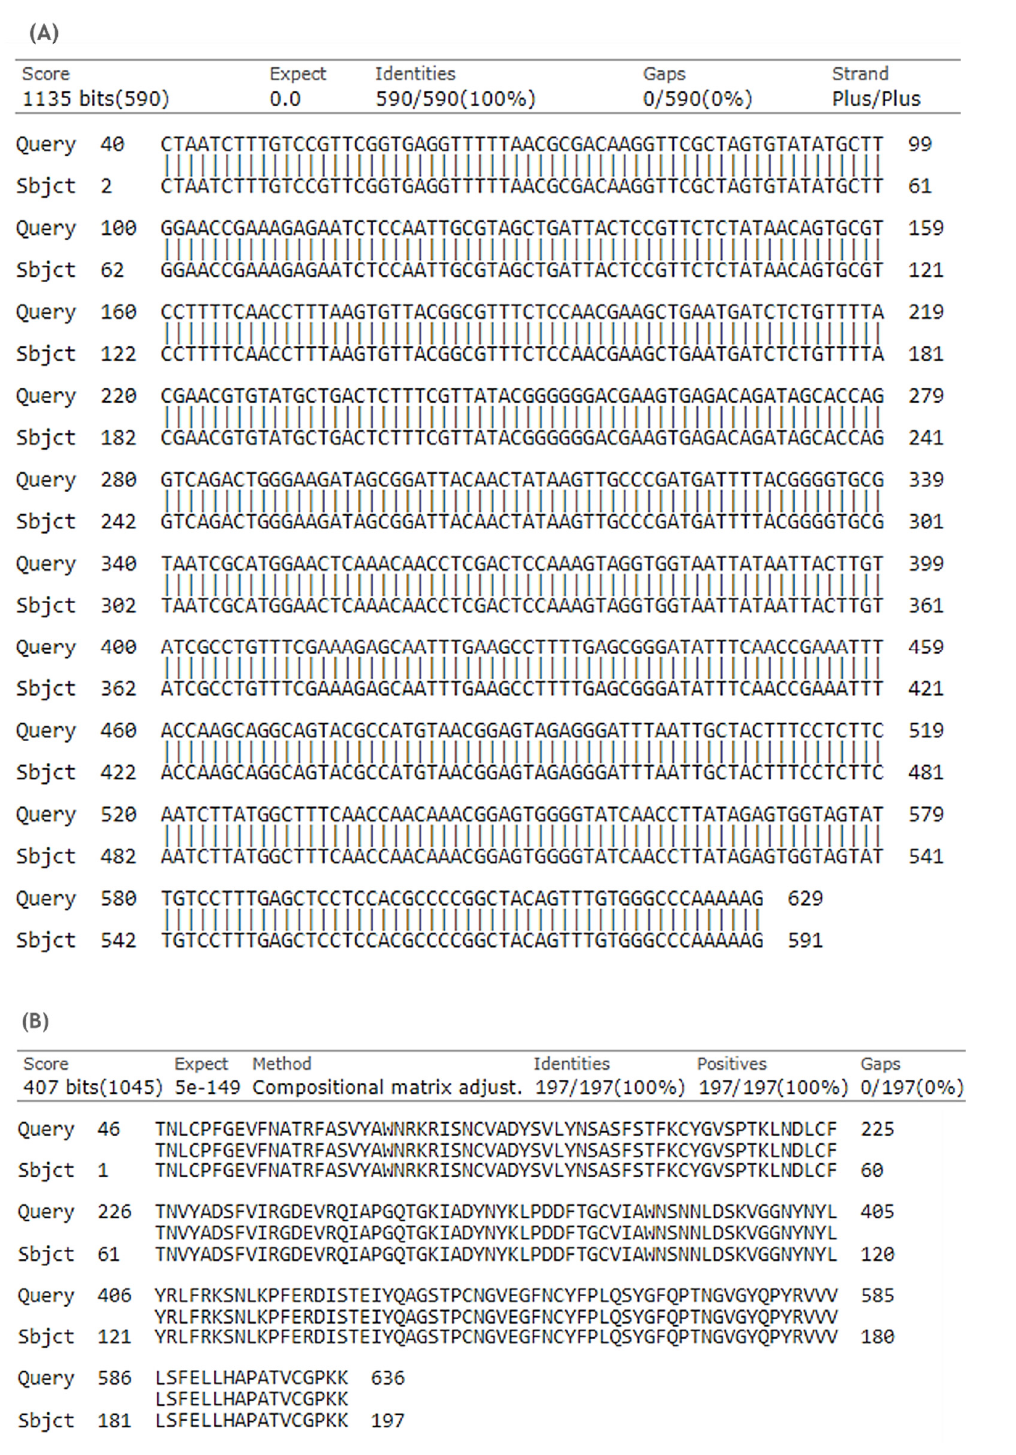
Figure 4. Alignments of RBD-cloned PP vector and RBD sequence performed with basic local alignment search tool (BLAST). ( A ) Nucleotide alignment. ( B ) Amino acid alignment. The query corresponds to PP-RBD vector sequence and the subject is the sequence corresponding to RBD (a.a. 333-529) of S protein from SARS-CoV-2 (NCBI reference sequence: NC_045512.2 (21563..25384)).